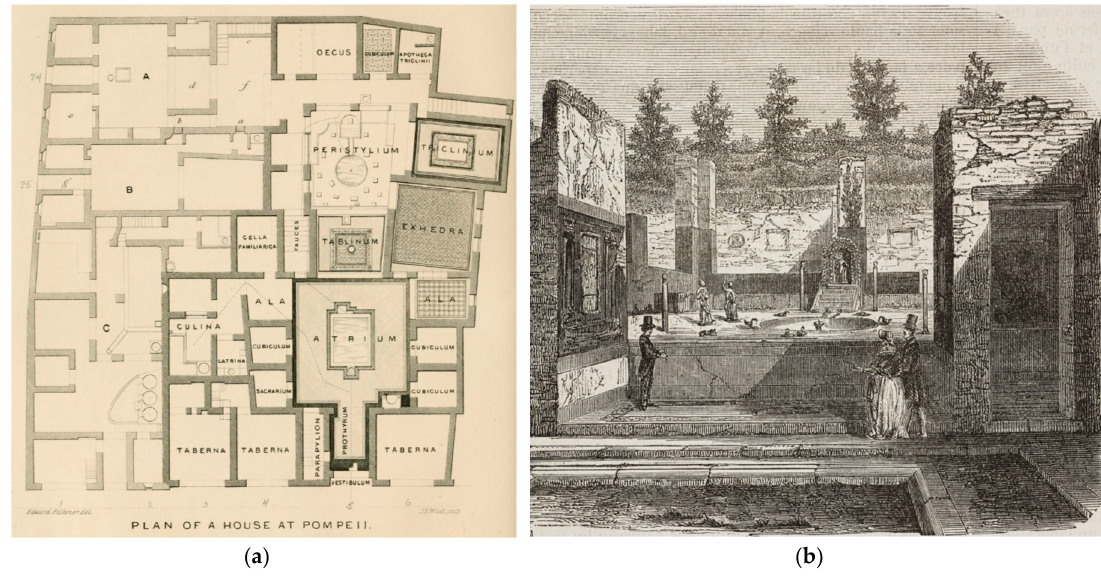
Figure 4. Floor plans of the House of Marcus Lucretius in Pompeii. Room 18 is marked as the “peristylum” in Falkener’s plan ( a ) Plan of a house at Pompeii: The House of Marcus Lucretius (IX, 3, 5.24). Illustration Courtesy: E. Falkener (used by permission); ( b ) Marcus Lucretius’ house, Pompeii, Italy. Illustration Courtesy: E. Breton (used by permission).